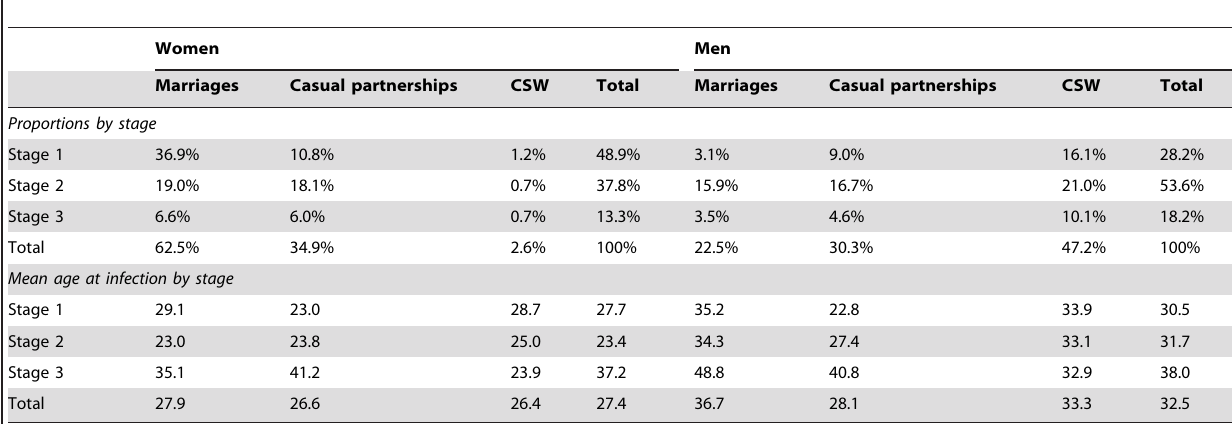
Table 2. Proportion of infections occurring at each stage of the disease in the partner, by type of relationship, and mean age at infection, by sex and type of relationship